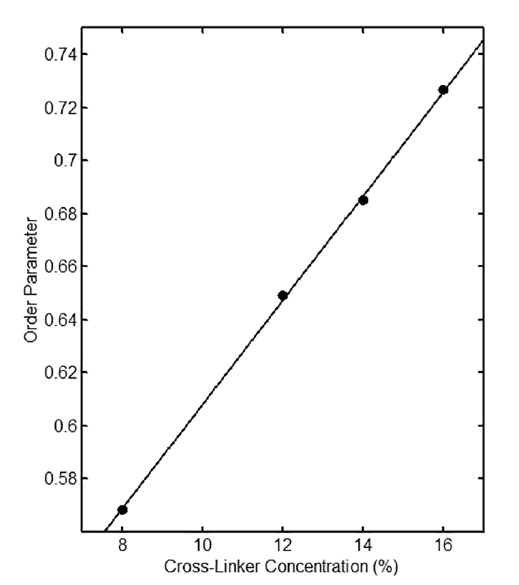
Figure 7. A linear regression of the maximum order parameter with respect to the cross-linker concentration, which shows that the higher cross-linker concentration has a higher maximum order